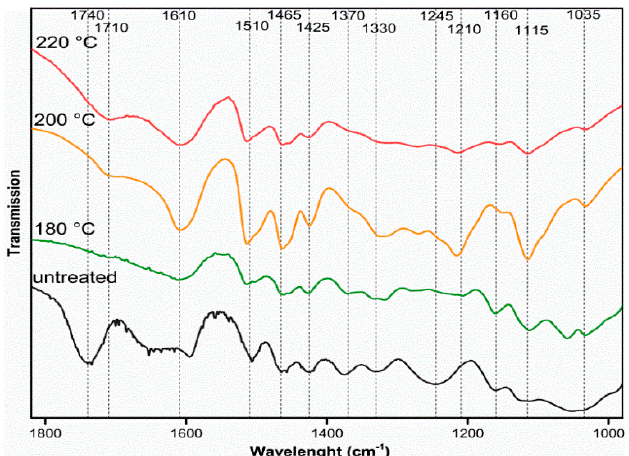
Figure 6. FT-IR spectra of untreated beech wood and solid residue after pretreatment with 0.05 mol L − 1 sulphuric acid at different temperatures; adsorption range from 1800 cm − 1 to 1000 cm − 1 .